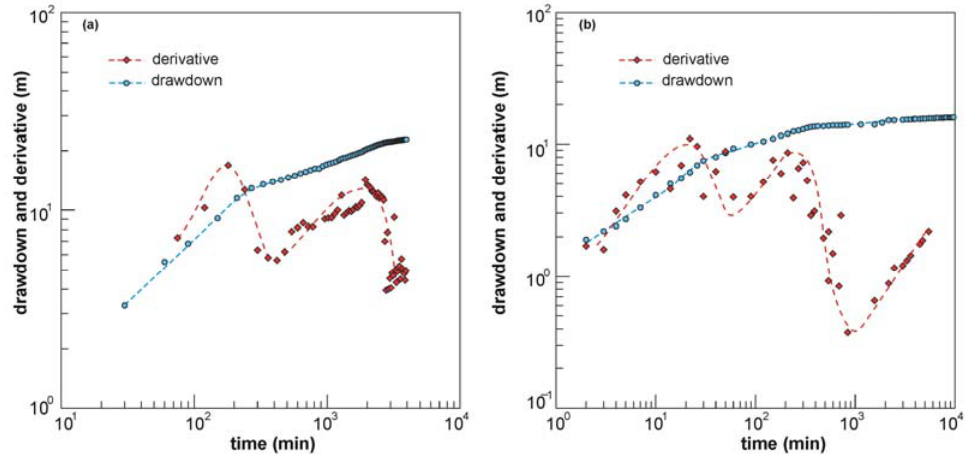
Figure 3. Diagnostic plot of drawdown monitored during unsteady state constant-rate pumping tests. ( a ) Data from piezometer of well TR5: double porosity model; ( b ) data of well MCAL2: triple porosity model.